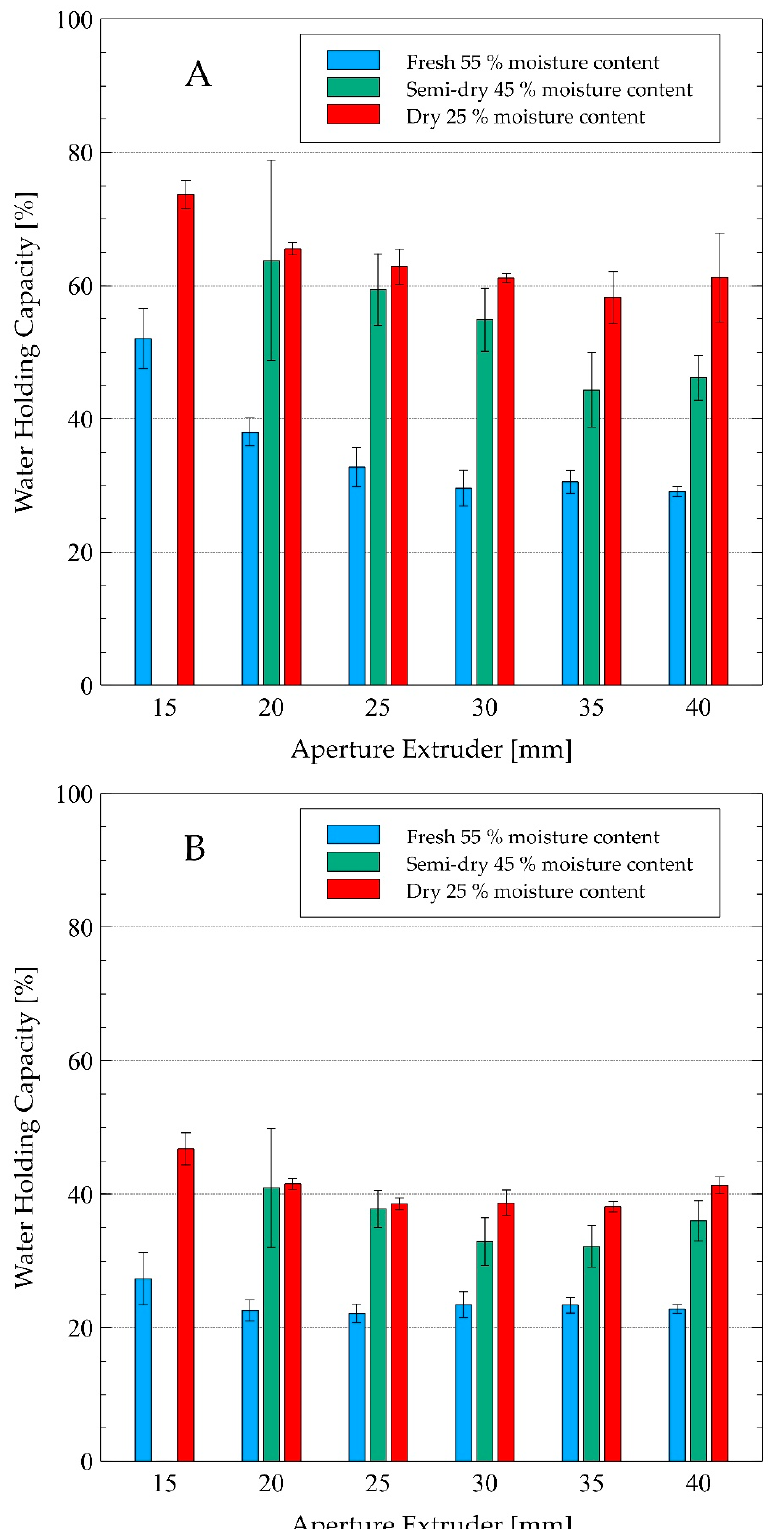
Figure 2. Volume-based WHC (DIN EN 13041) of − 1 kPa ( A ) and − 5 kPa ( B ). Comparison of fresh, semi-dry, and dry extruded poplar.